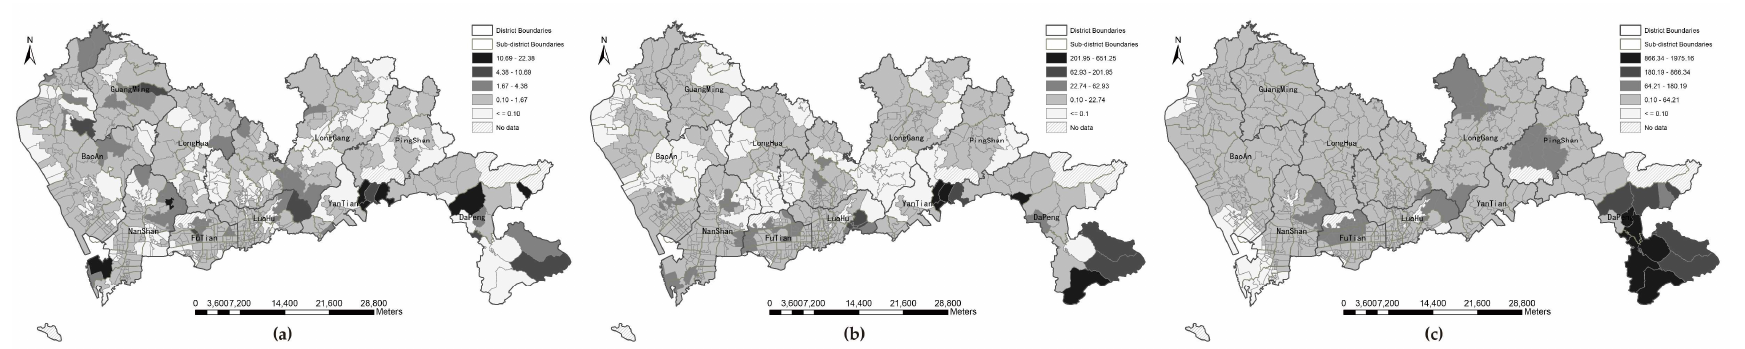
Figure 8. Park accessibility by bicycling distance at three park levels: ( a ) community park level; ( b ) city park level; ( c ) natural park level.